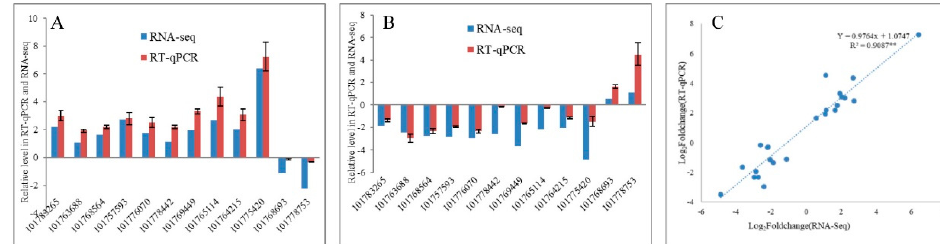
Figure 3. Comparison of the expression profiles of selected DEGs determined by RT-qPCR and RNA-Seq analyses. ( A , B ) Expression levels of 12 DEGs in drought stress and re-watering conditions. Values are presented as log 2 ( fold-change ) . The X -axis represents gene ID, according to the NCBI database. ( C ) Scatter plots of the expression levels of 12 DEGs in drought stress and re-watering conditions. X and Y axes represent log 2 (fold-change) determined by RT-qPCR and RNA-seq experiments, respectively; ** p < 0.01.